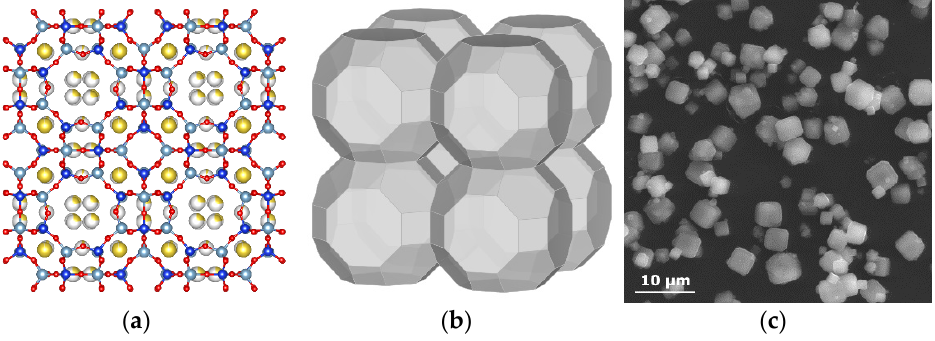
Figure 1. Zeolite Na-A crystal lattice: ( a ) model structure of zeolite Na-A; ( b ) simplified representa- tion of zeolite A crystal structure highlighting the atomic cavities occupied by cations (prepared with the use of VESTA software [10] based on the .cif file available on the [2]); ( c ) SEM image of zeolite A.